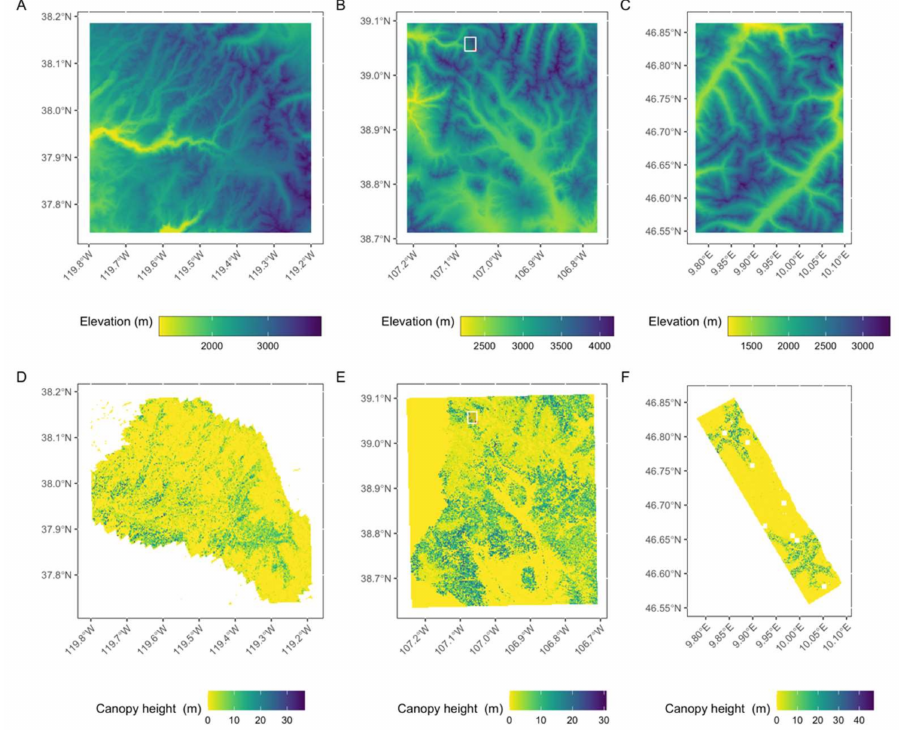
Figure 2. Elevation and canopy height for ( A , D ) Upper Tuolumne, USA, ( B , E ) Upper Gunnison, USA, and ( C , F ) Engadin, Switzerland.